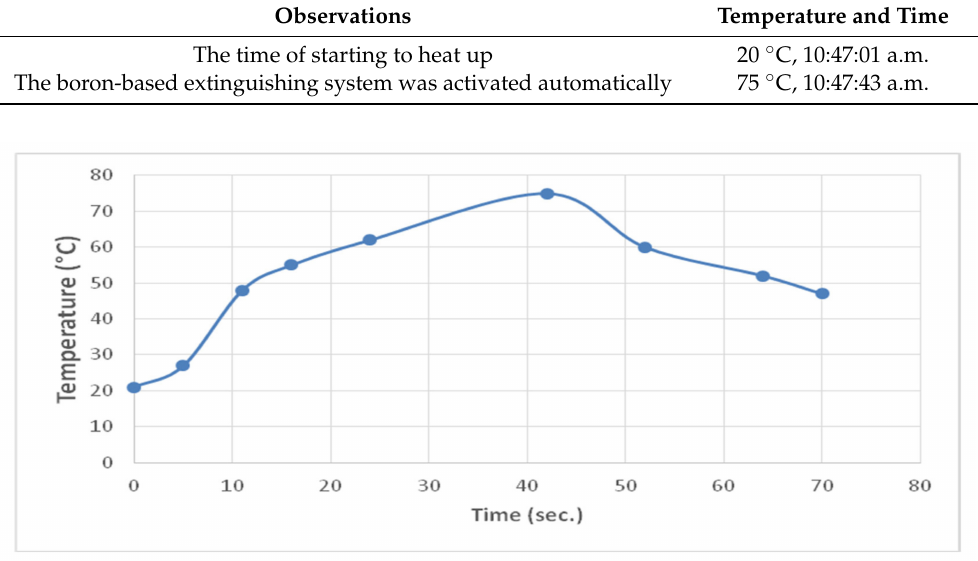
Figure 26. Exp. B.2 results (temperature/time